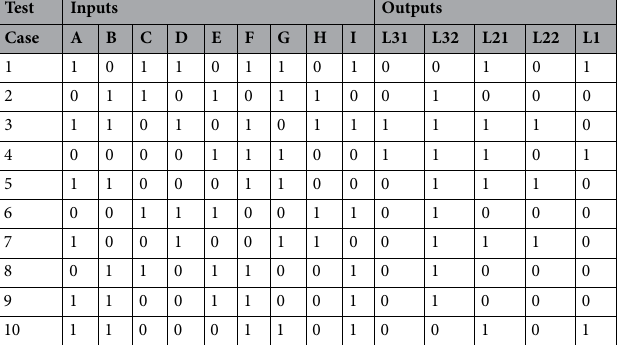
Table 9. Truth table for standard CMOS circuit